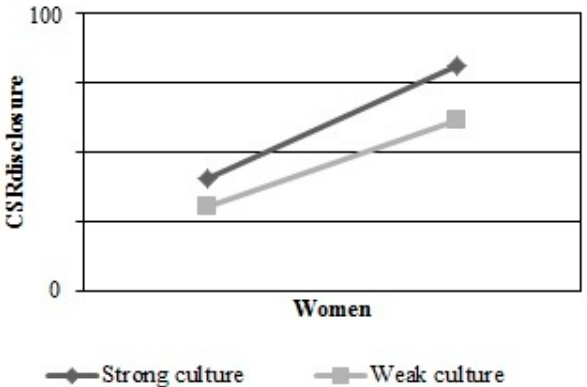
Figure 2. Moderating effect of the cultural context on the link between female directors and CSR disclosures.